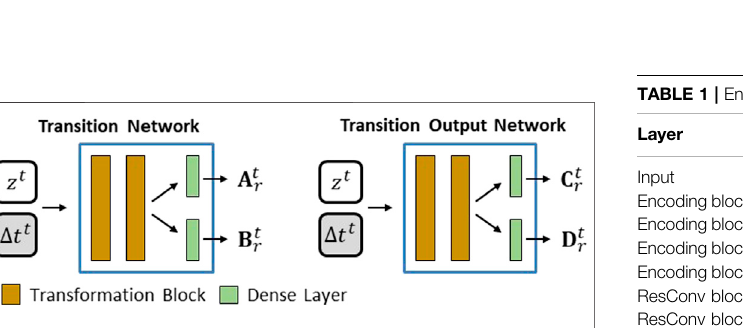
FIGURE 10 | Transition network (left) (Adapted from [2]) and Transition Output network (right) .